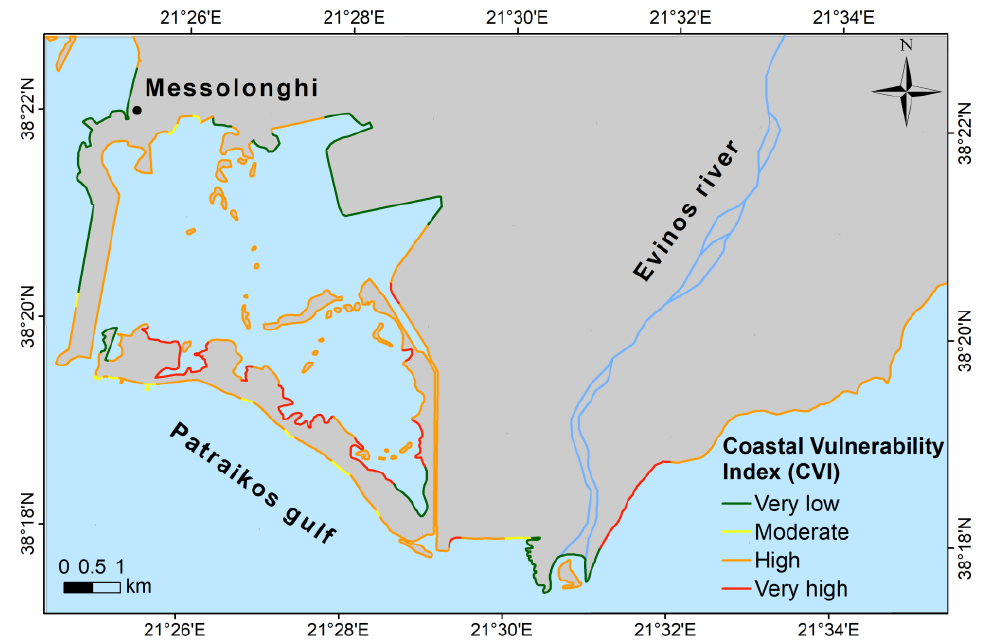
Figure 5. The results of the vulnerability assessment for the study area: Coastal Vulnerability Index (CVI) using all variables.